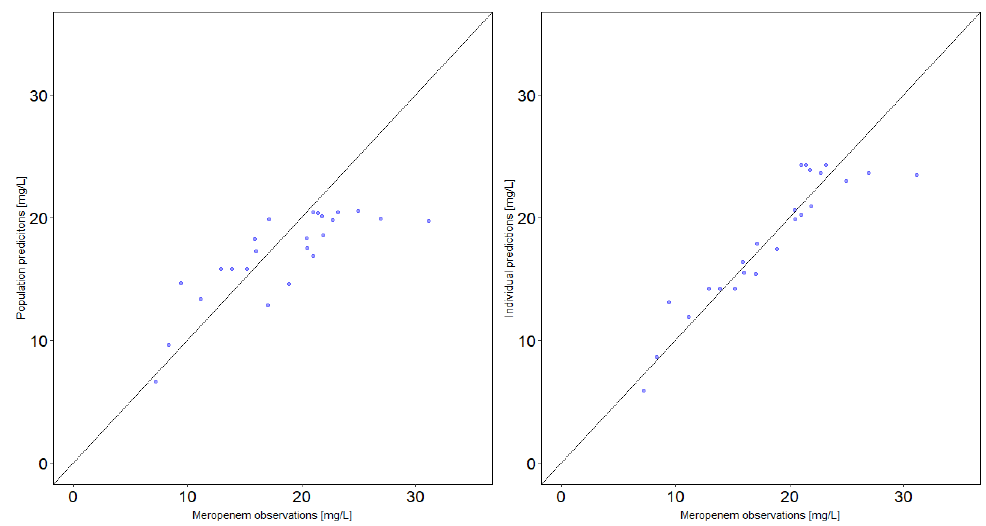
Figure 4. Goodness-of-fit plots for the final population pharmacokinetic model of meropenem in six critically ill patients. Left figure: Population-predicted concentrations versus observed concentrations. Right figure: Individual-predicted concentrations versus observed concentrations. Lines: Line of unity.